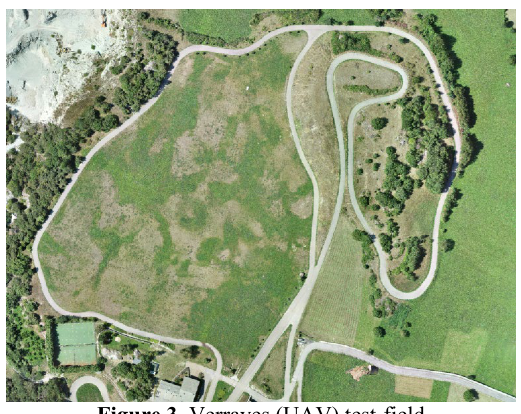
Figure 3 . Verrayes (UAV)